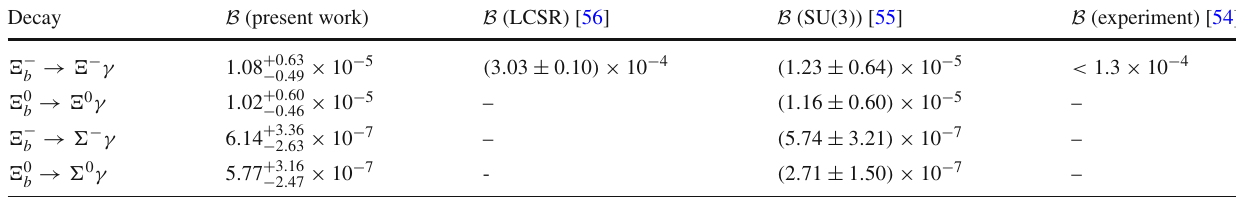
Table 5 Branching ratios for different channels obtained in the present study compared with the results of previous LCSR, SU(3) flavor symmetry method and existing experimental data